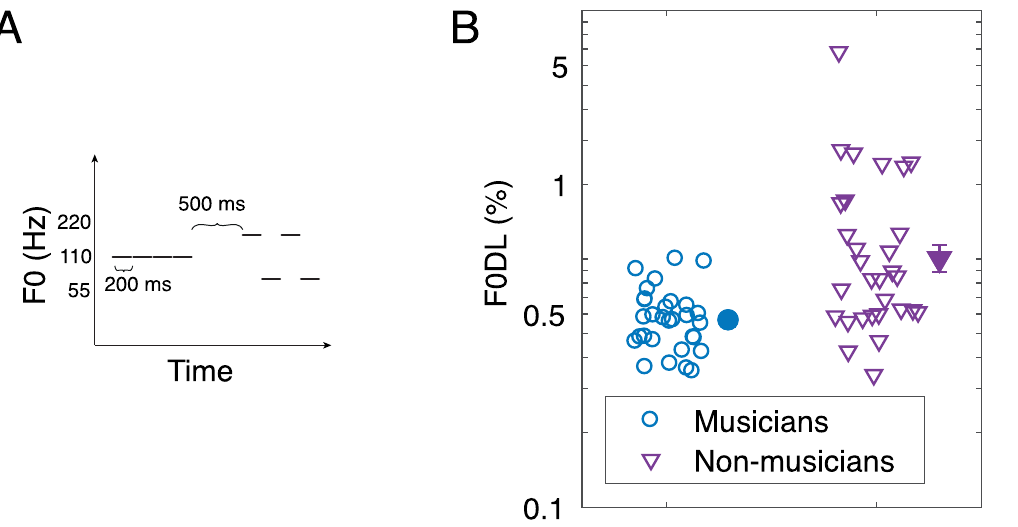
Figure 1. Fundamental frequency difference limens (F0DLs) for musicians and non-musicians. ( A ) Schematic diagram of the stimuli used in the experiment. ( B ) Individual thresholds for each participant (open symbols) are shown, along with group means (solid symbols). Errors bars represent ± 1 standard error of the mean across